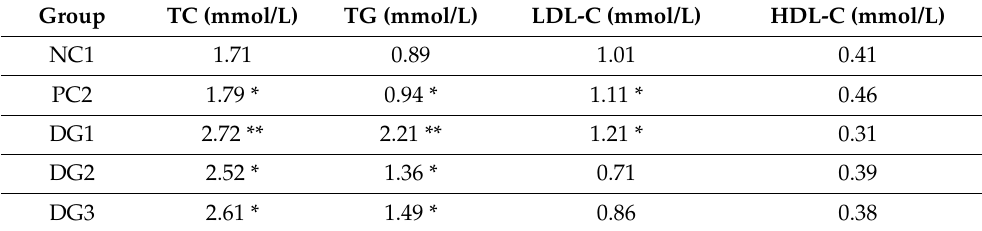
Table 7. Effects of aqueous extract of C. roseus on serum TC, TG, LDL-C, and HDL-C in diabetic rats.